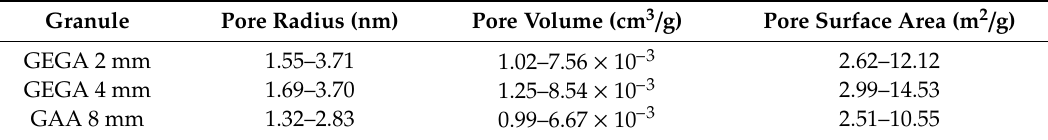
Table 4. Lightweight aggregate granule pore structural analysis.